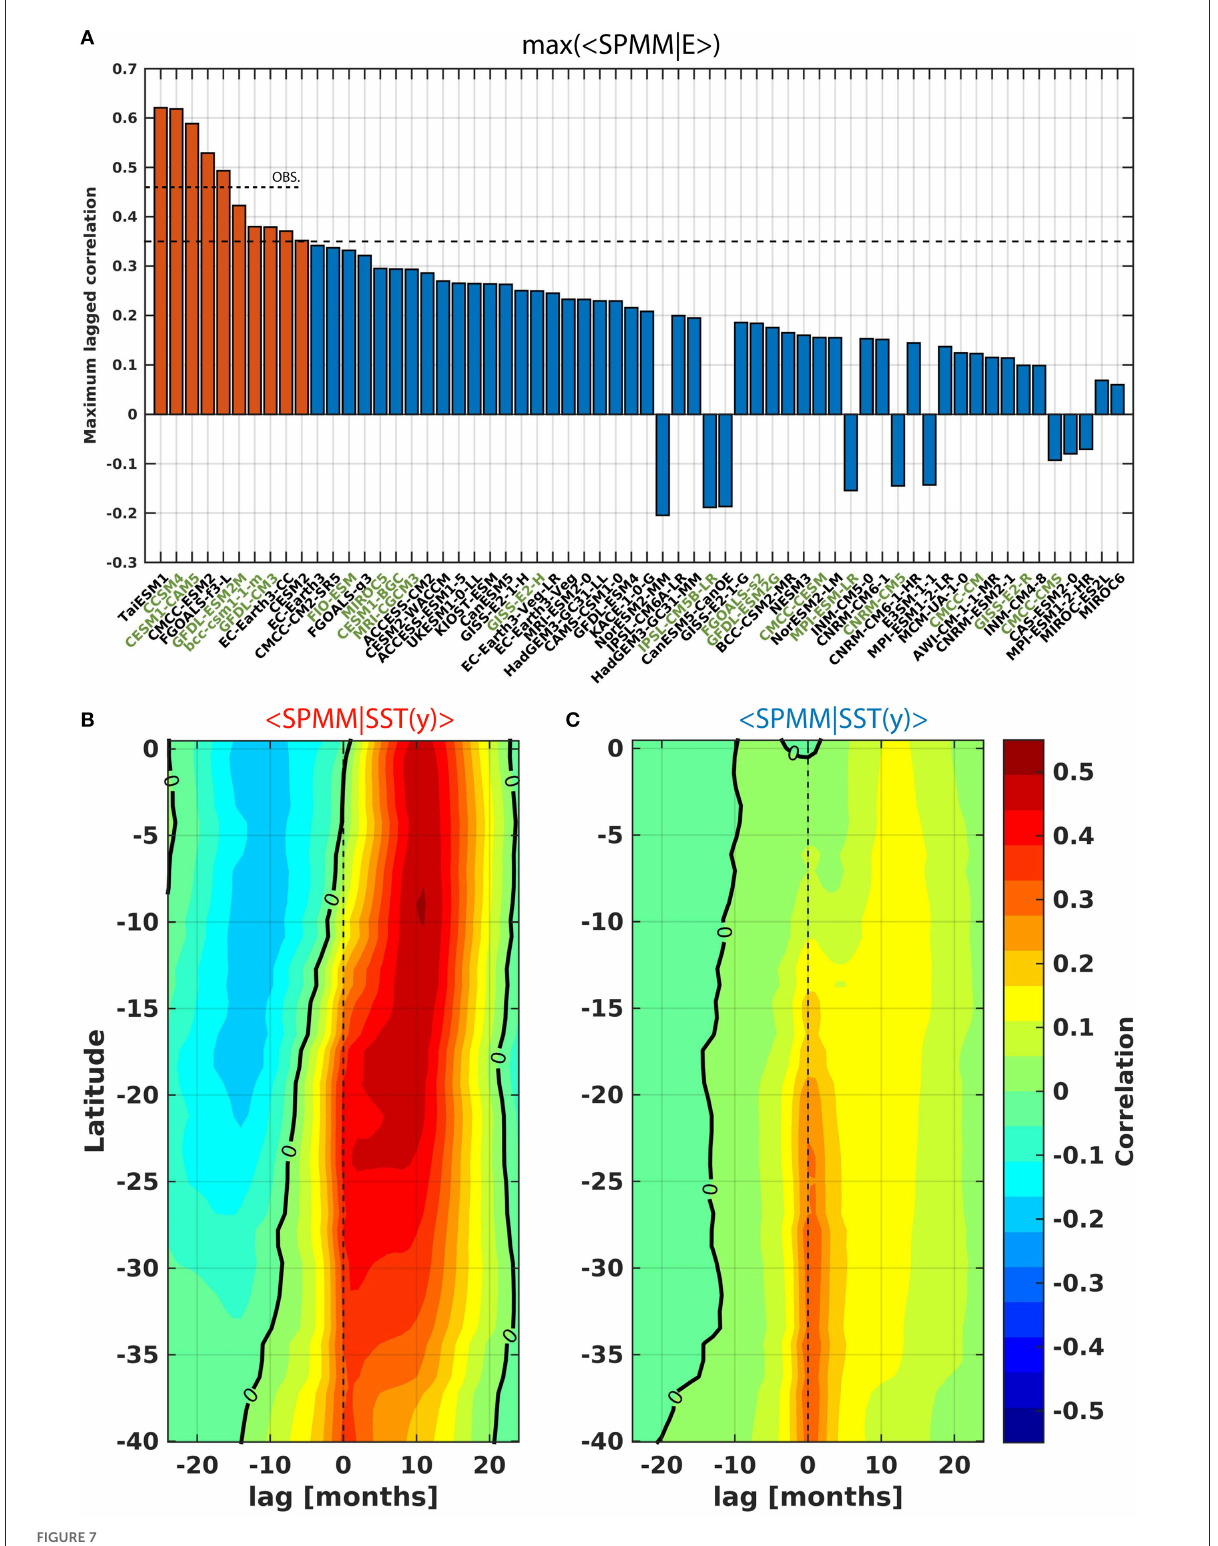
FIGURE7 The SPMM/E relationship in models participating to CMIP Phases 5 and 6: (A) maximum/minimum correlation between the SPMM and E indices (lag of maximum correlation is provided in Table 1). The model names in black are for CMIP6 while those in light green are for CMIP5; Ensemble mean lead-lagged correlation between the SPMM index and SST anomalies along the coast (2 ◦ width coastal fringe) between the equator and 40 ◦ S (B) amongst models with a “strong” SPMM/E relationship [red bars in (A) ] and (C) amongst models with a “weak” SPMM/E relationship [blue bars in (A)